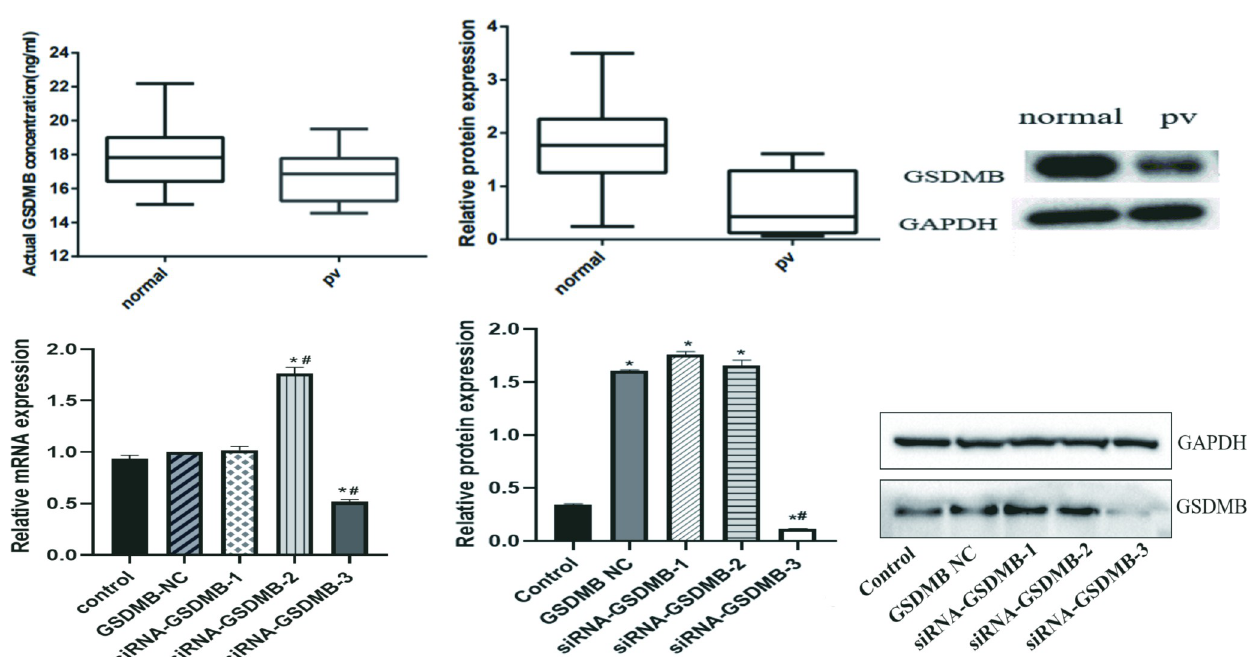
Fig 1. GSDMB in pathogenesis of psoriasis vulgaris. (A) GSDMB levels in skin tissues detected by ELISA. PV group compared with normal group, � P < 0.05. (B) GSDMB levels in skin tissues detected by Western blot. PV group compared with normal group, � P < 0.05. (C) mRNA expression levels in each group were detected by qPCR. Compared with the control group, � P < 0.05; compared with GSDMB-NC, # P < 0.05. (D) Western blot was used to detect the protein expression levels in each group. Compared with the control group, � P < 0.05; compared with GSDMB-NC, # P < 0.05.